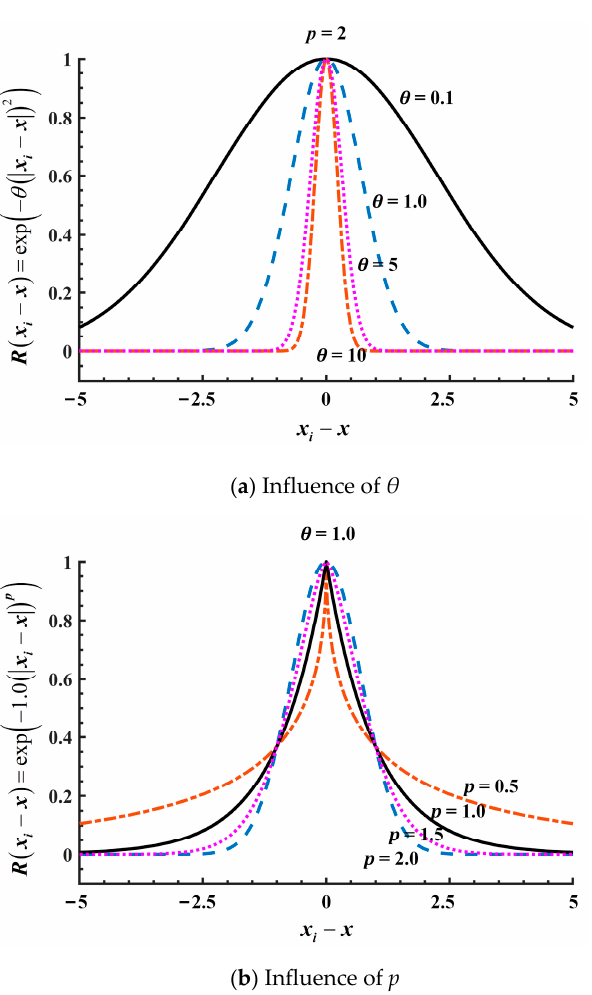
Figure 2. Gaussian exponential function indicator function with different parameters.